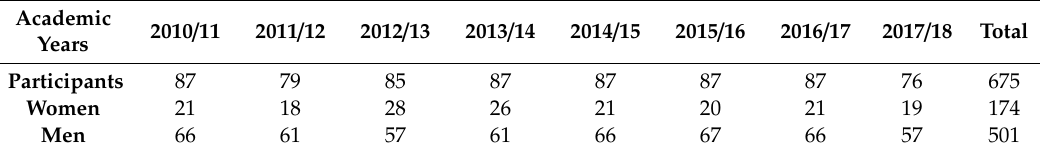
Table 1. Distribution of students throughout the academic years analyzed, according to